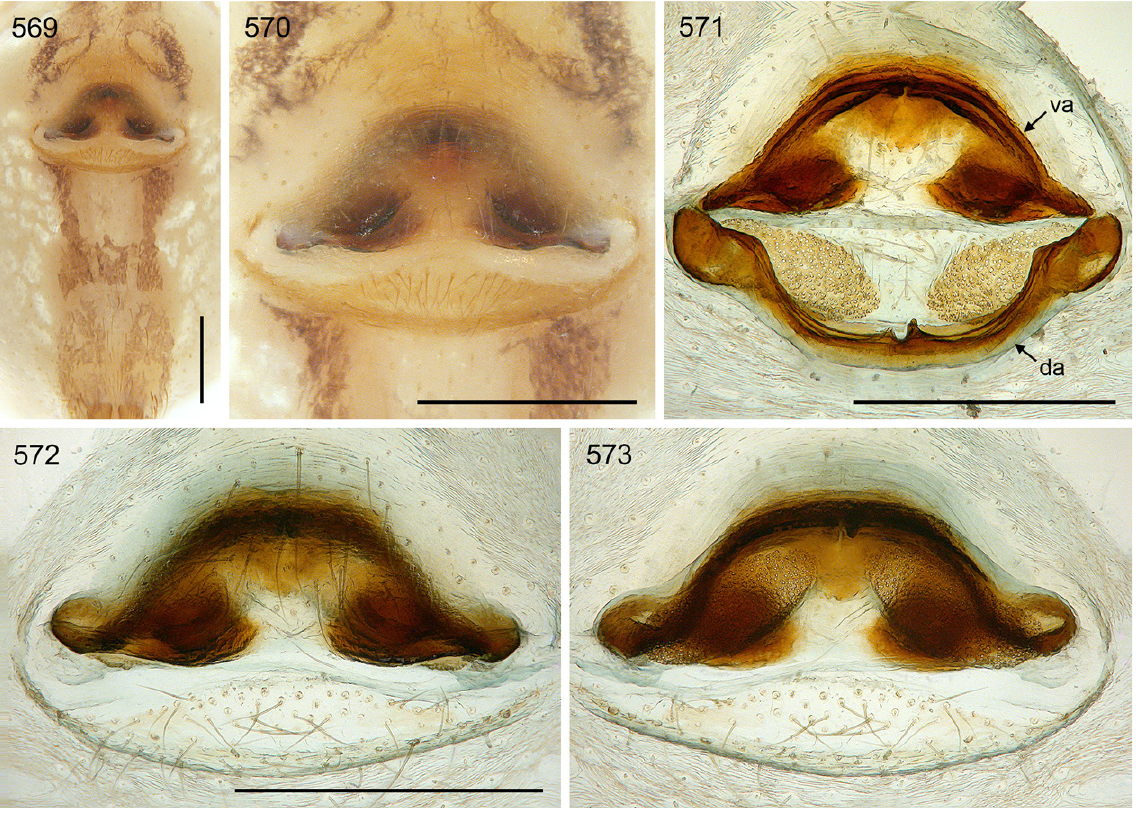
Figs 569–573. Crossopriza khayyami sp. nov., female from Iran, Fars, Izad Khast (MHNG). 569– 570 . Abdomen and epigynum, ventral views. 571–573 . Female internal genitalia, dorsal view (with dorsal arc tilted backwards), ventral view, and regular dorsal view. Abbreviations: da = dorsal arc; va = ventral arc. Scale bars = 0.5